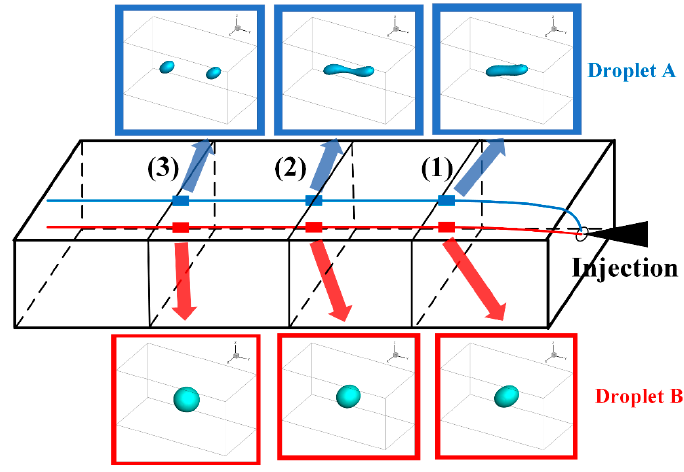
Figure 10. Trajectories and morphologies of the droplets A and B.